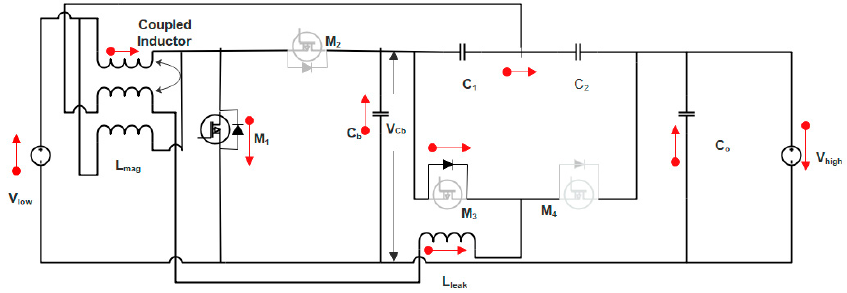
Figure 5. Equivalent circuit for mode III.